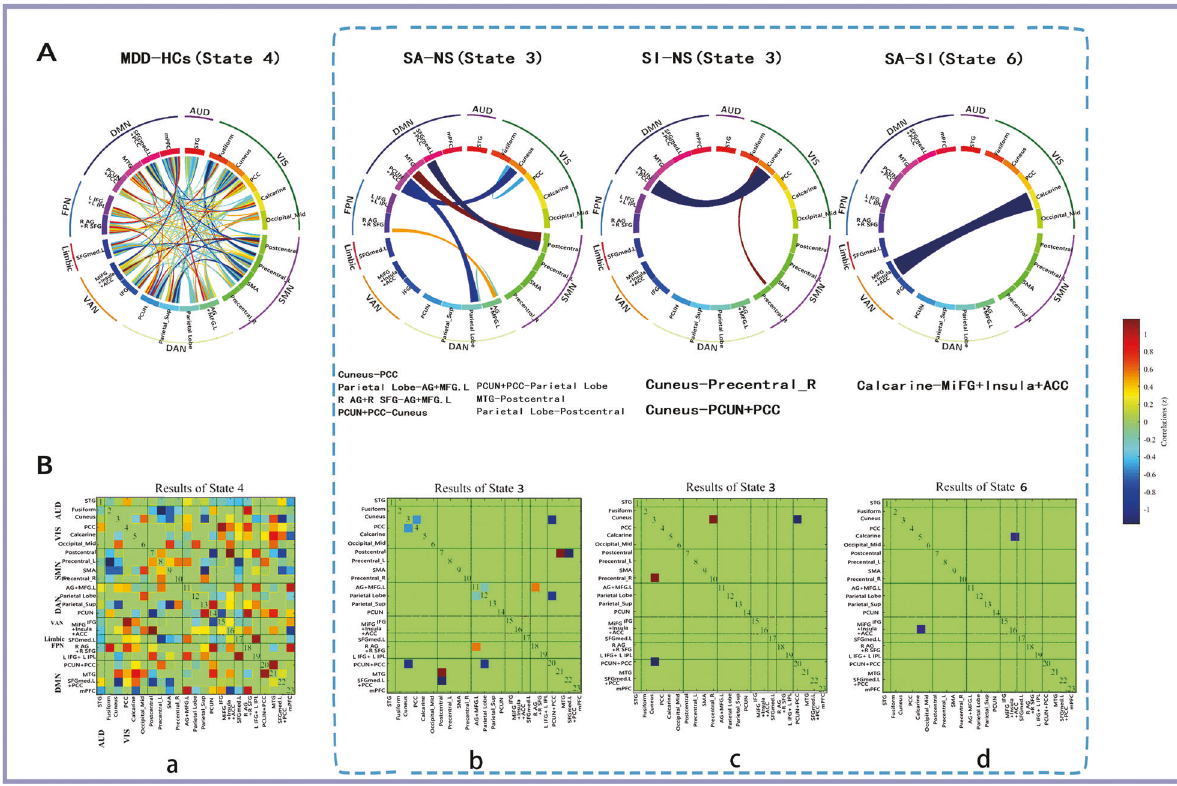
Fig. 5 Consensus functional connections in distinguishing patients with major depressive disorder (MDD) from HCs and in distinguishing suicidality among MDD patients. The brain region of each cluster is represented by a square on the circumference of the big circle. The lines connecting two squares represent the connections between the corresponding two brain regions. The thickness of the line represents the support vector classi fi cation weight of the connection. The thicker the line, the larger the weight. Red lines represent positive weight, while blue lines represent negative weight. AUD auditory network, VIS visual network, SMN somatomotor network, DAN dorsal attention network, VAN ventral attention network, LN limbic network, FPN frontoparietal network, DMN default mode network, L left, R right, STG superior temporal gyrus, Fusiform fusiform gyrus, Cuneus cuneus cortex, PCC posterior cingulate cortex, Calcarine calcarine cortex Occipital_Mid middle occipital gyrus, Postcentral postcentral gyrus, Precentral precentral gyrus, SMA supplementary motor area, AG angular gyrus, MFG middle frontal gyrus, Parietal_Sup superior parietal gyrus, PCUN precuneus, IFG inferior frontal gyrus, MiFG middle inferior frontal gyrus, lnsula insular cortex, ACC anterior cingulate cortex, SFGmed superior frontal gyrus medial, SFG superior frontal gyrus, IPL inferior parietal lobule, MTG middle temporal gyrus, mPFC medial prefrontal